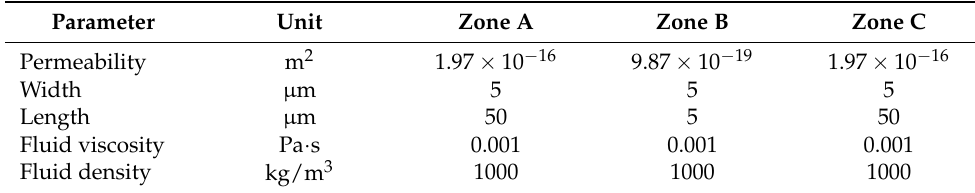
(cid:0) (cid:1) 1M = 1000 mol/m 3 .